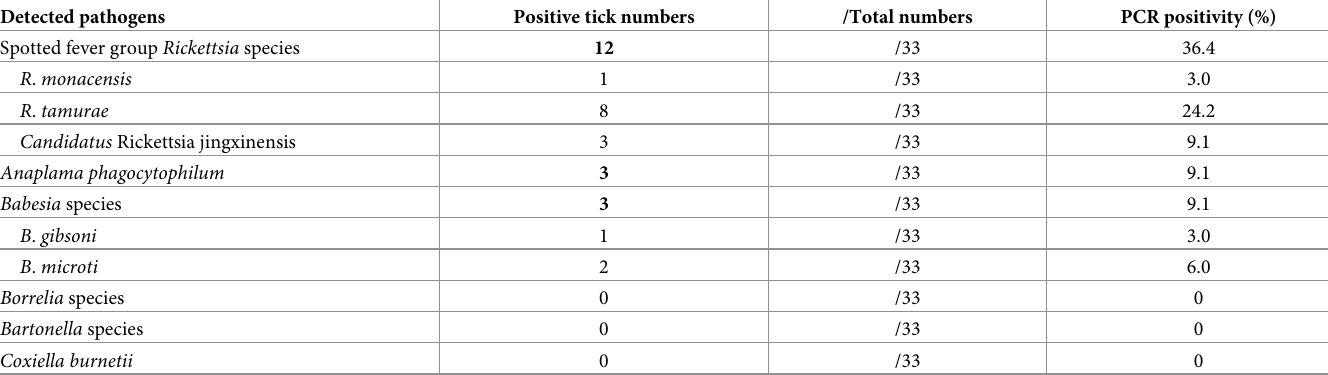
Table 4. Detection of tick-borne pathogens in ticks via pathogen-specific nested PCR. Detected